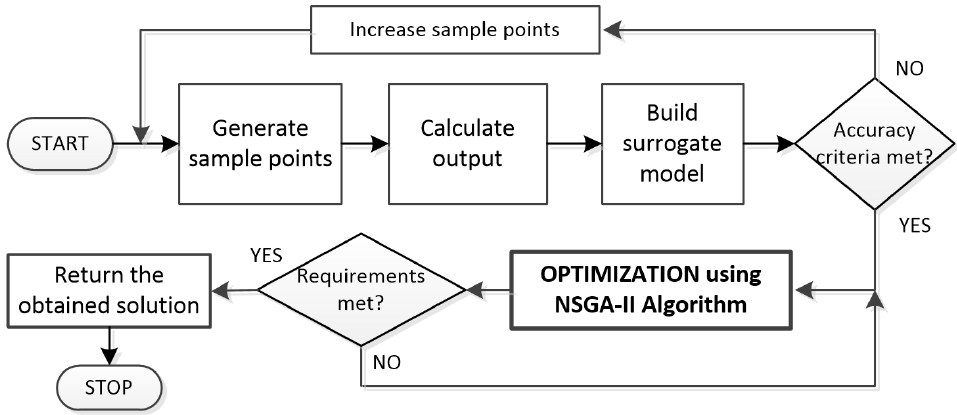
Figure 13. Algorithm of multi-objective genetic optimization of an on-off valve by [54].